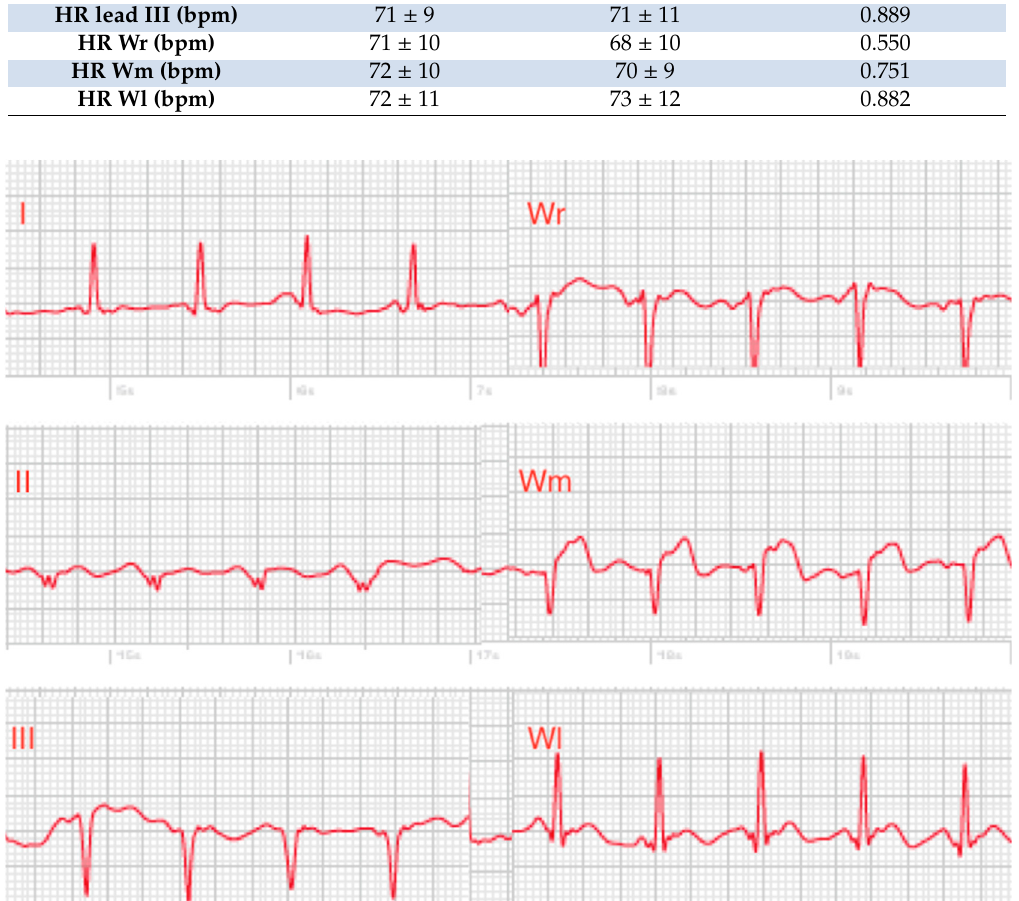
Figure 3. Smartwatch ECGs of a patient with acute anterior myocardial infarction with clear ST-elevations in lead Wm. (I = Einthoven lead I, II = Einthoven lead II, III = Einthoven lead III, Wr = pseudo-unipolar recording corresponding to standard lead V1, Wm = pseudo-unipolar recording corresponding to standard lead V4, Wl = pseudo-unipolar recording corresponding to standard lead V6).